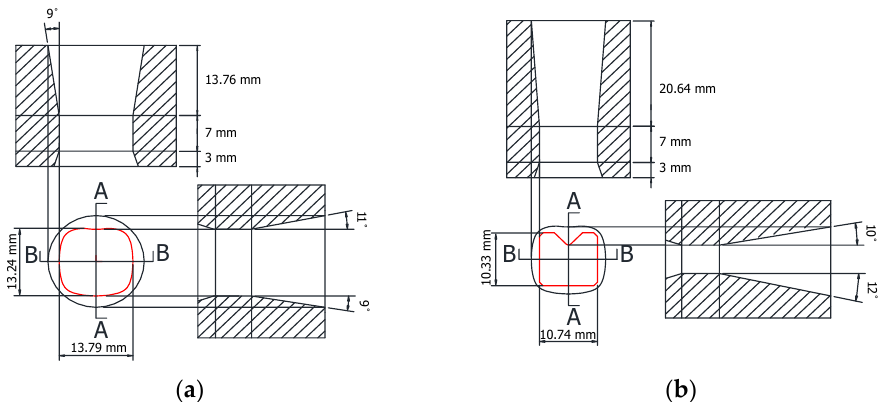
Figure 8. Geometry of the drawing dies designed using the equipotential line method for the cross-roller guide: ( a ) first pass; ( b ) second pass.